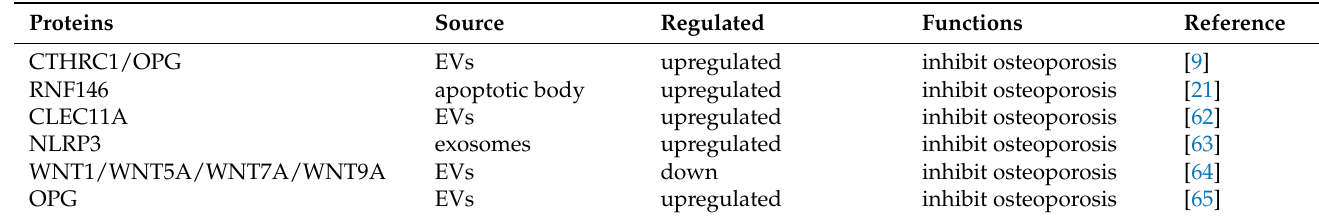
Table 2. The role of EV-associated proteins in